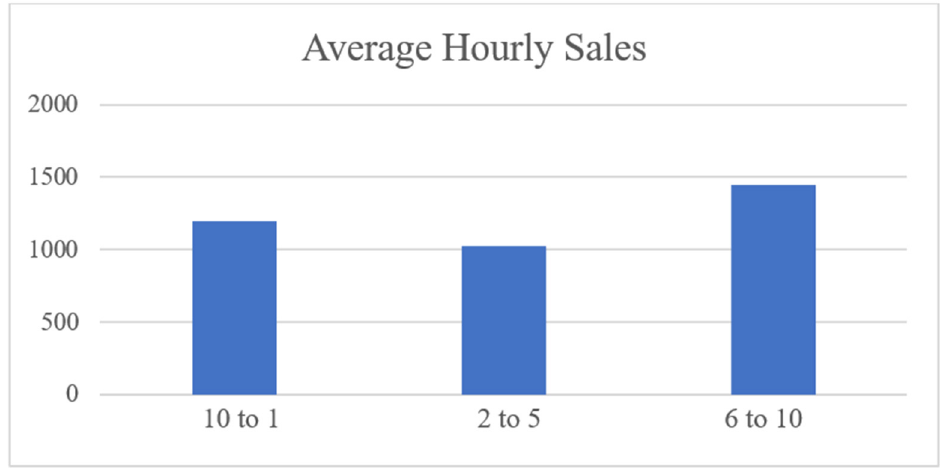
Figure 2. Average Sales (3-Bin Partitions).